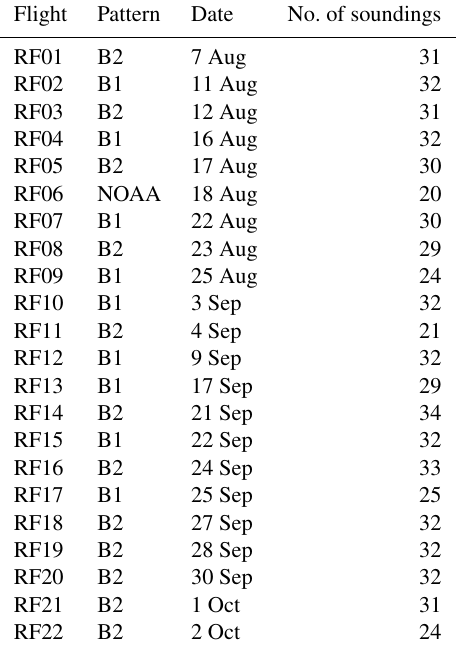
Table 1. Overview of all successful sonde releases during OTREC.